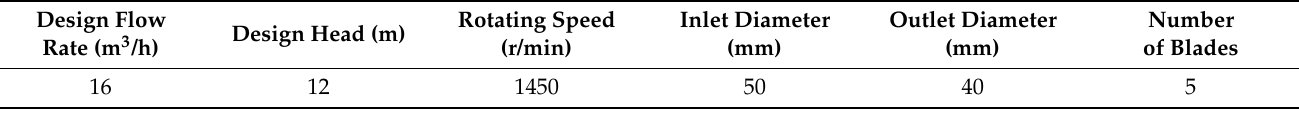
Table 1. Main design parameters of centrifugal